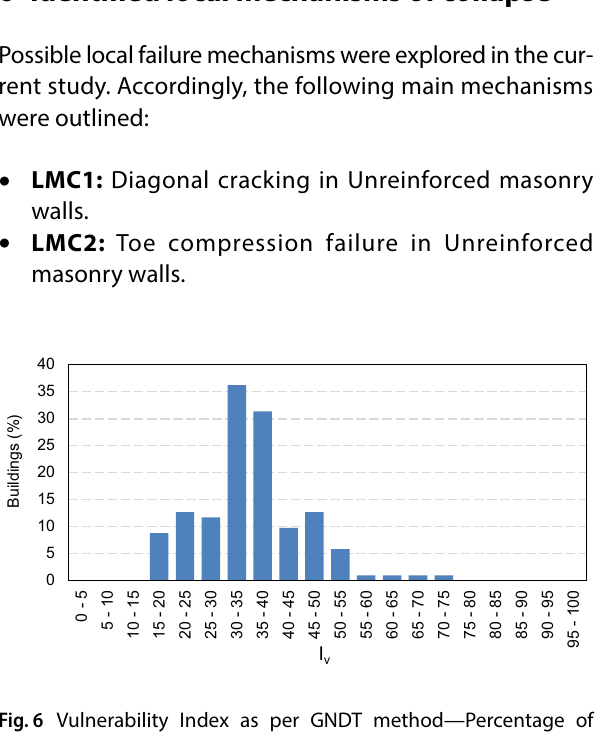
Fig. 5 Vulnerability index as per GNDT method—Number of build- ings